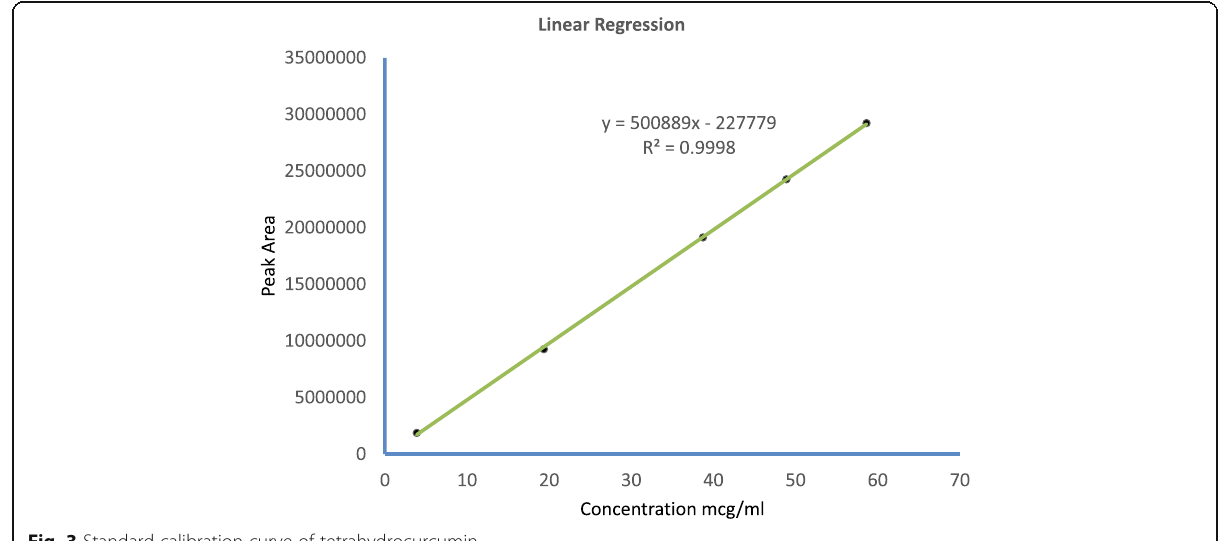
Fig. 3 Standard calibration curve of